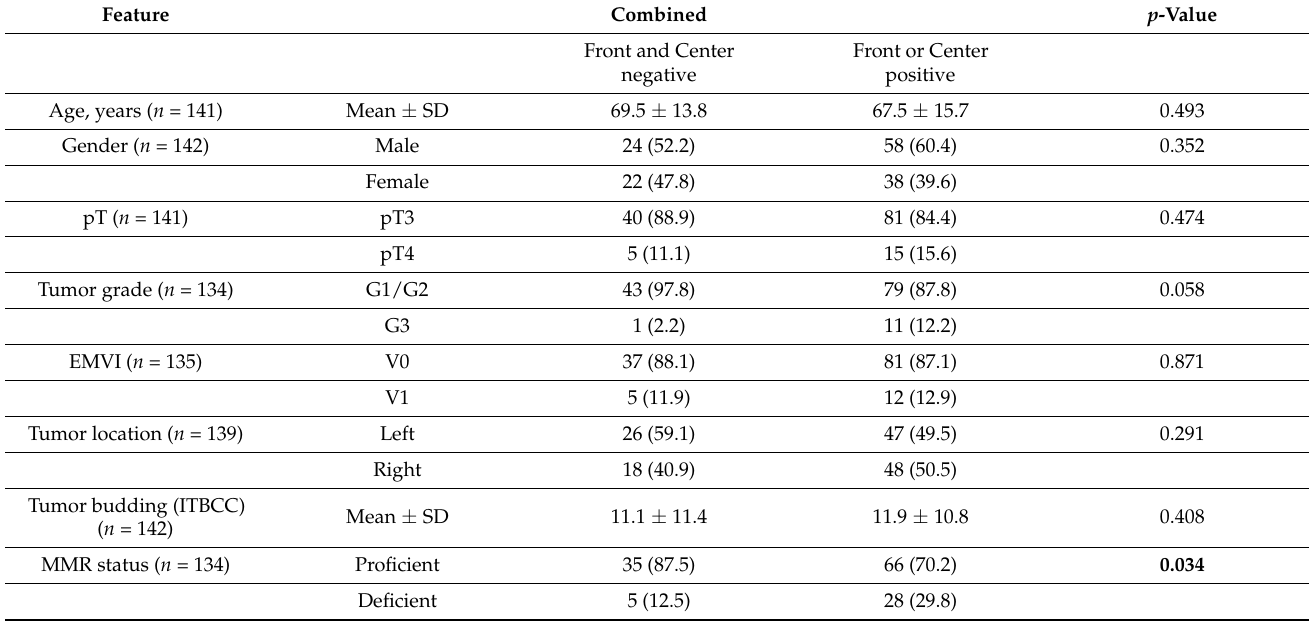
Table 1. Association of LAG-3 (combined tumor front and center) with clinicopathological features on the stage II colon cancer